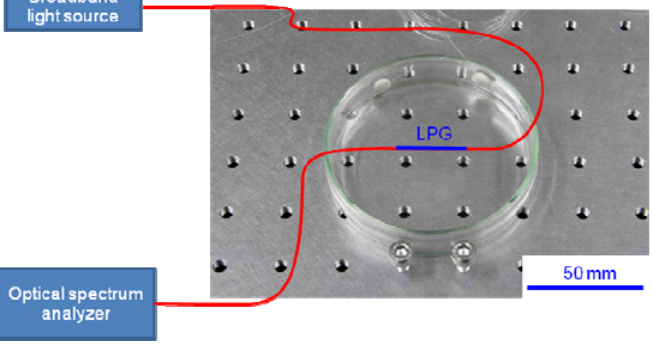
Figure 1. Experimental setup for measuring the transmission spectrum of a straight